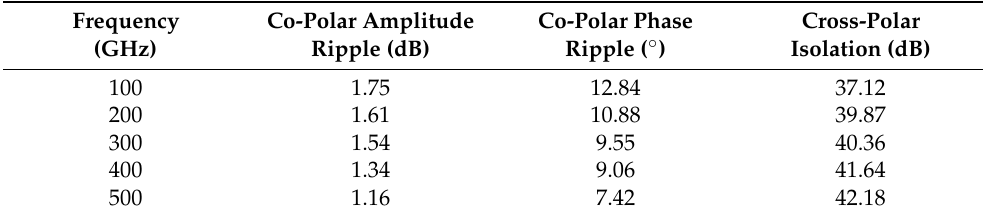
Table 2. Quiet zone performance of the designed tri-reflector compact antenna test range (CATR) on principal cuts (quiet zone diameter 2.25 m).